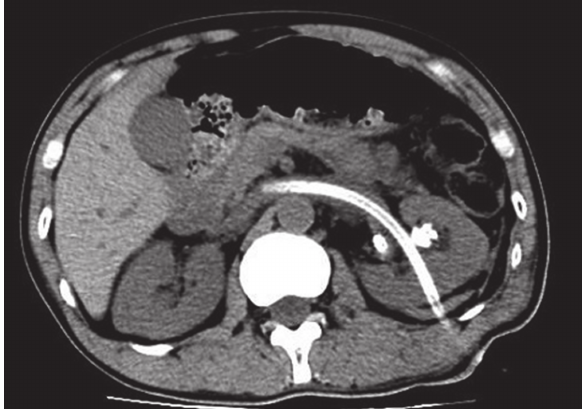
figure 1 - Computed tomography revealing the nephrostomy tube piercing the renal parenchyma, into the left renal vein and ending in the inferior vena